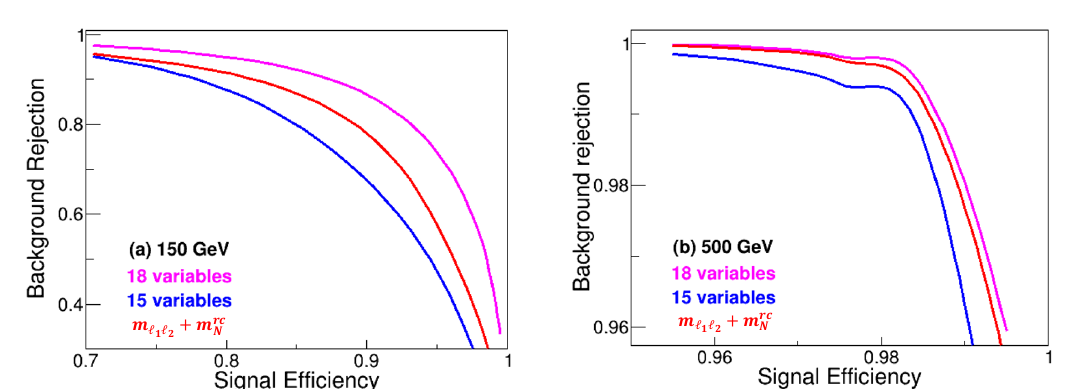
Figure 13 . Background rejection versus signal efficiency for different sets of variables in MLP at √ s = 14 TeV in the 0-jet channel for m N = 150 GeV (left) and 500 GeV (right). The magenta, red and blue lines are, respectively, for all the 18 variables in figure 4 to 6, the variables m and m rc , 1 , and the rest 15 N